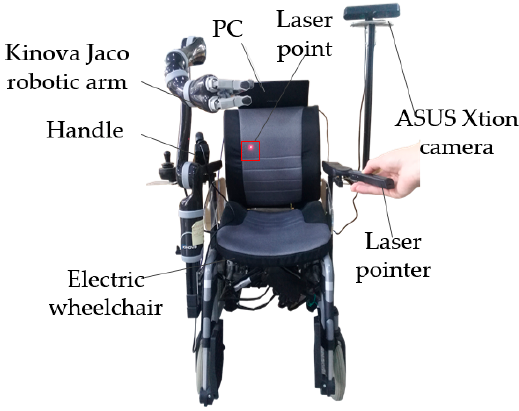
Figure 11. Experimental platform.